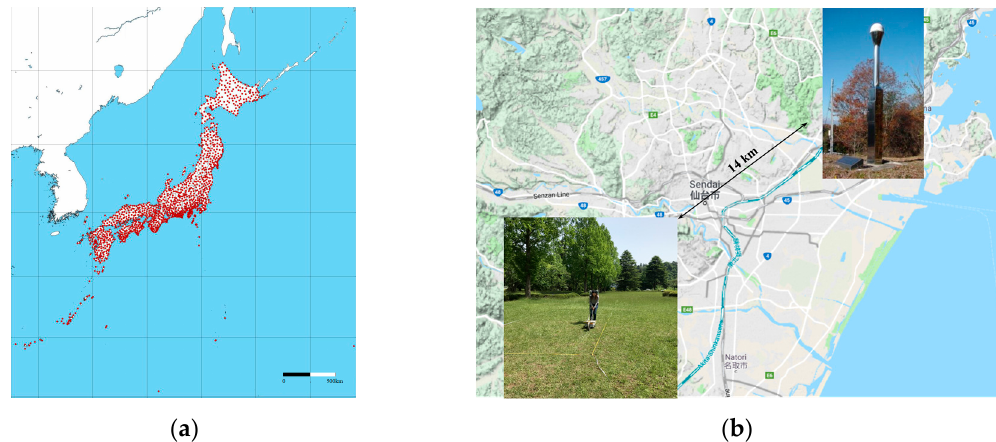
Figure 4. ( a ) The location of the GEONET stations in Japan; ( b ) location of the investigation site and nearest GEONET Station.